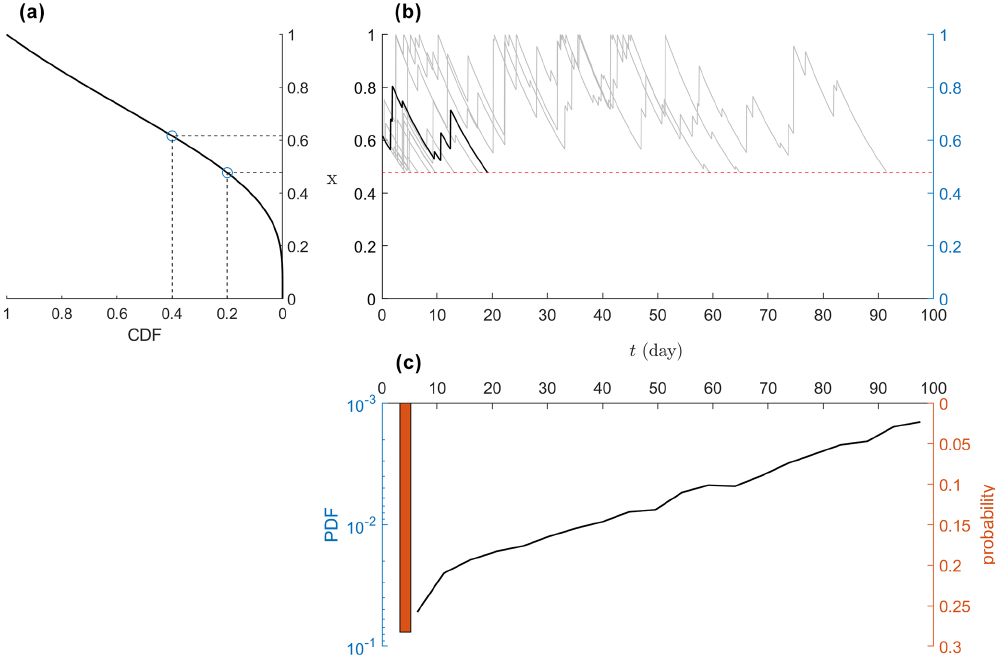
Figure 2. (a) Quantile function for soil moisture (i.e., the inverse of Eq. 4) along with the 20th and 40th percentiles of soil moisture marked by circles. (b) Numerical simulation of Eq. (1) for relative soil moisture x from 40th to 20th percentiles, where rainfall is assumed to be a Poisson process. (c) The empirical distribution of first passage time (sample size of 1000). The parameters are set as follows: average rainfall depth α = 12mm, rainfall rate λ = 0 . 3d − 1 , water storage capacity w 0 = 83 . 2mm, and potential evapotranspiration E max = 5mmd − 1 . Note that the continuous part of the distribution tends to be exponential (i.e., linear in the logarithmic scale for the y axis) not only for the parameters given in this example but also in the parameter space of Fig.